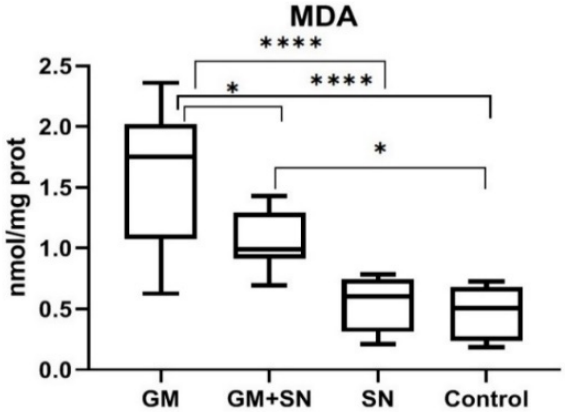
Figure 3. Malondialdehyde (MDA) level in the investigated groups (* p < 0.05, **** p < 0.0001). GM—gentamicin group, GM+SN—gentamicin and Sambucus nigra group, SN— Sambucus nigra group, Control—control group (no treatment).